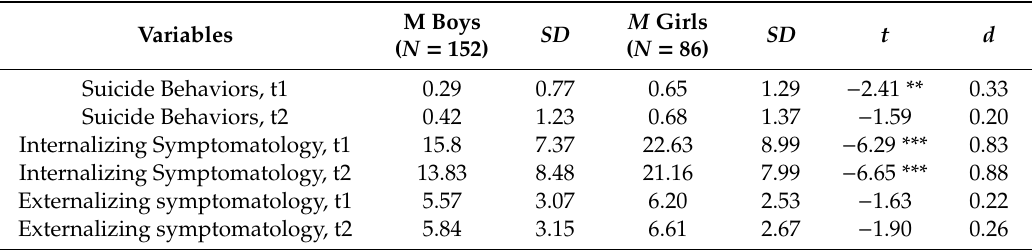
Table 1. Mean (M), standard deviation (SD), di ff erences between boys and girls, student’s t-test (t), e ff ect size (d) (N = 240).